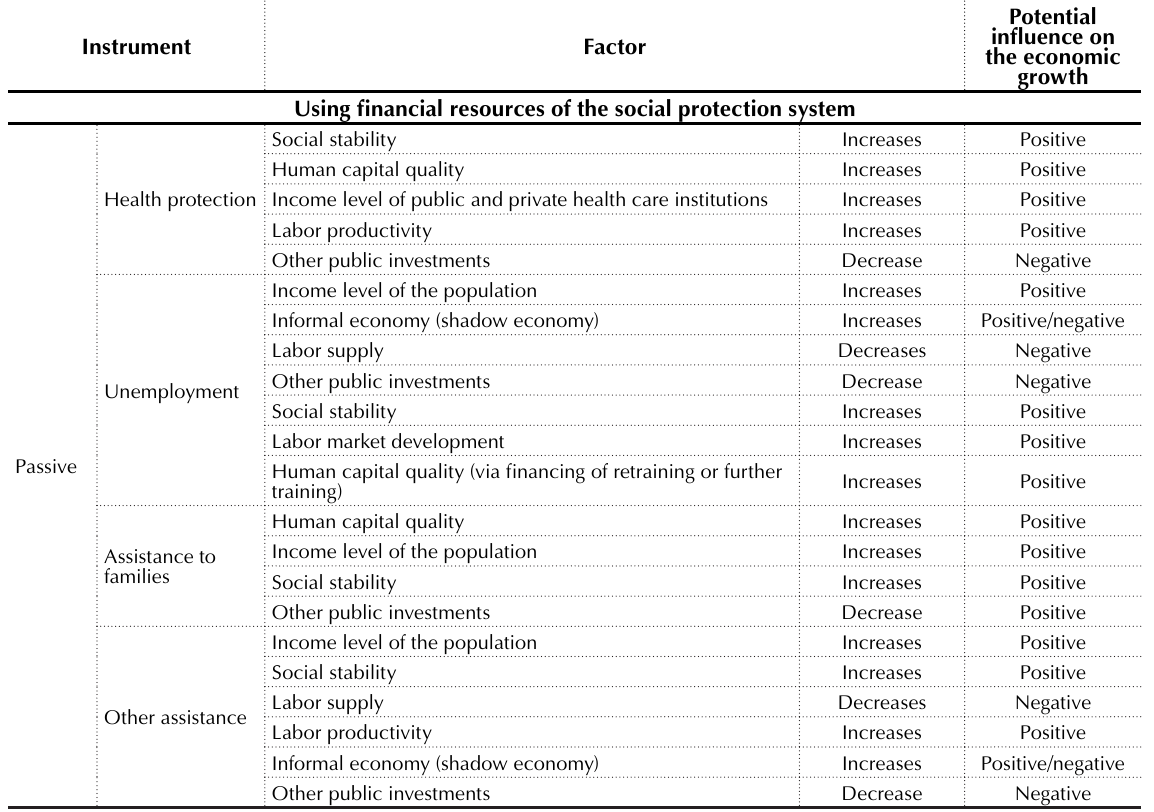
Table 1 (cont.). Analysis of the social protection impact on the factors determining economic